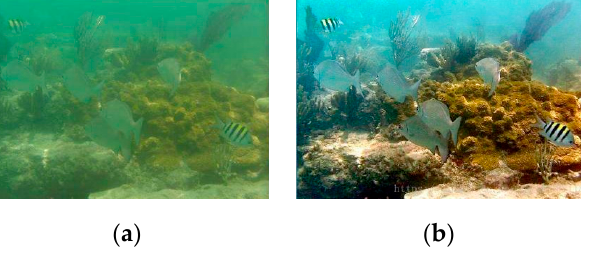
Figure 3. Comparison of images before and after underwater image processing. ( a ) Before analysis of the image. ( b ) After analysis of the image.